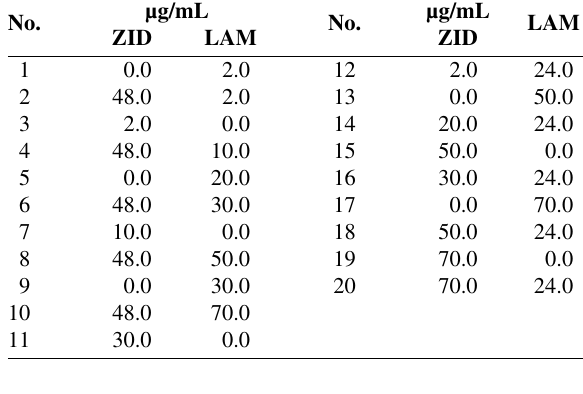
Table 1. Calibration set for PLS and PCR calibrations methods